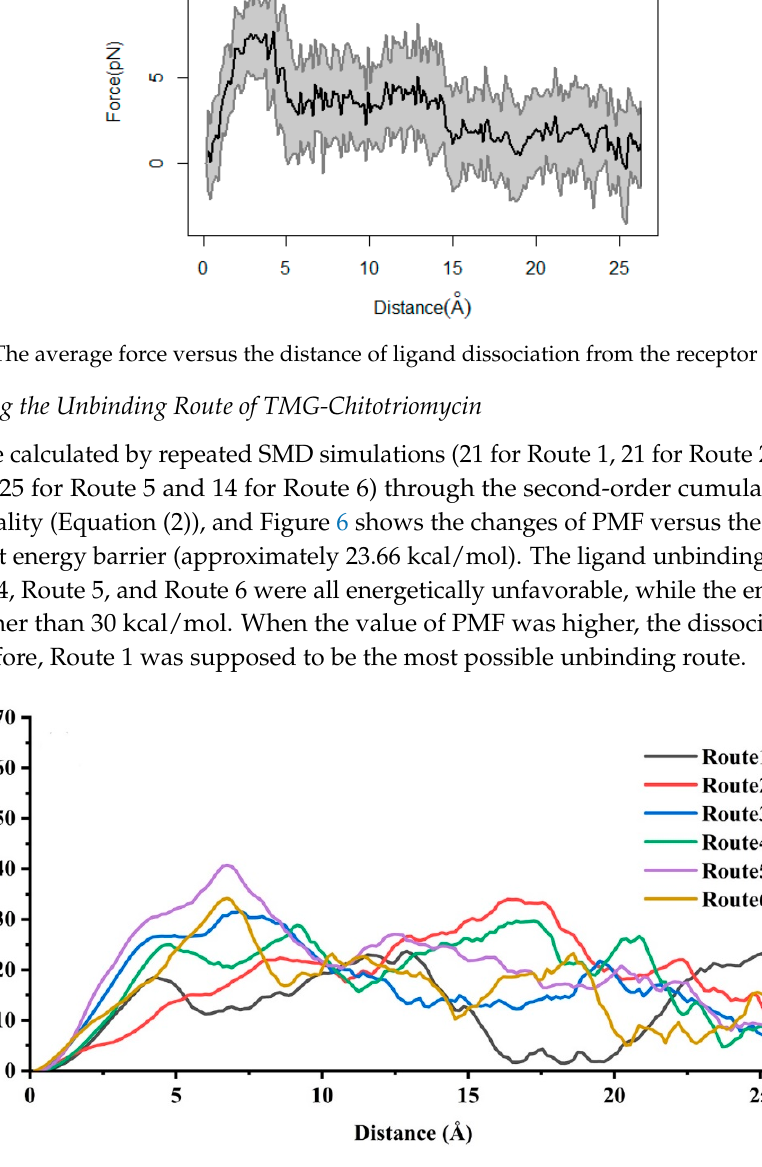
Figure 6. Potential of mean forces (PMFs) of TMG-chitotriomycin dissociation from O f Hex1 in different directions versus the distance.